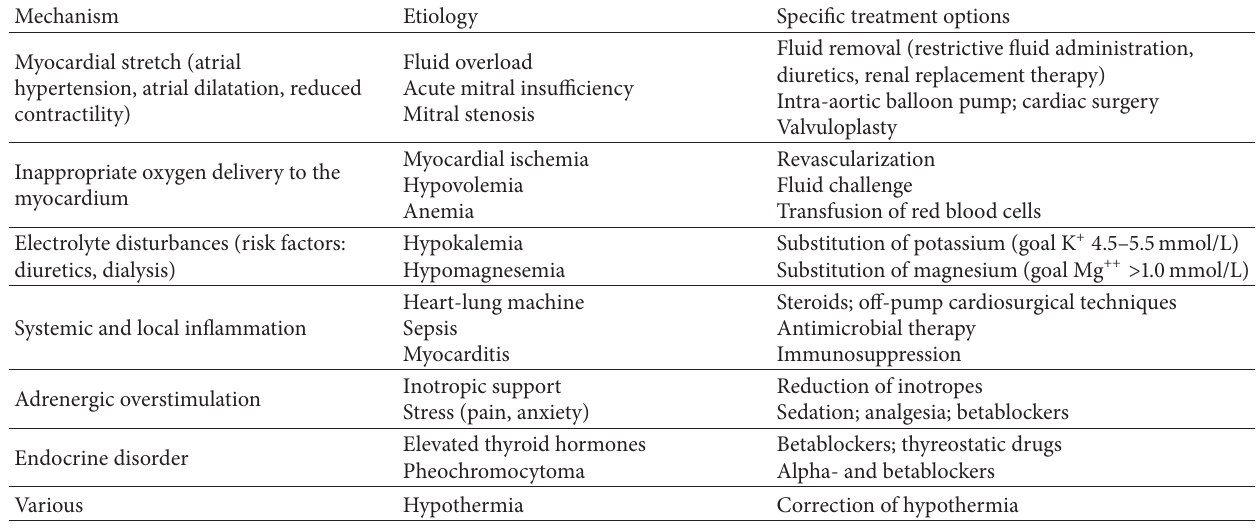
Table 1: Modifiable promoters of atrial fibrillation.